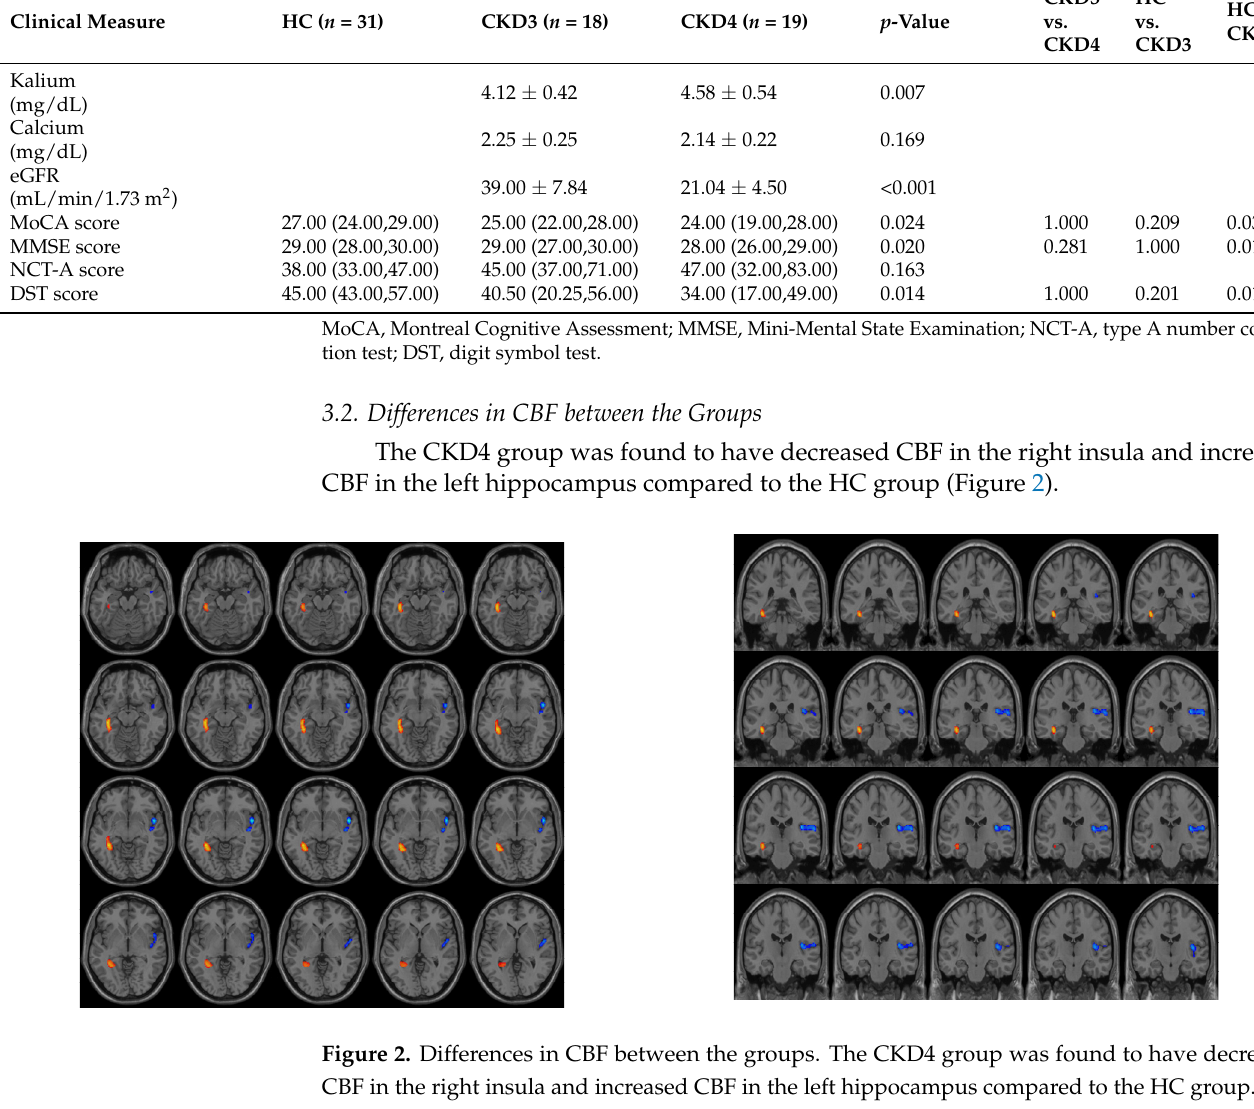
In the CKD4 sample, partial correlation analysis found that CBF in the right insula was negatively correlated with NCT-A scores (r = − 0.544, p = 0.024); CBF in the left hippocampus was positively correlated with BUN (r = 0.649, p = 0.005) and negatively correlated with serum calcium (r = − 0.646, p = 0.005) (Figure